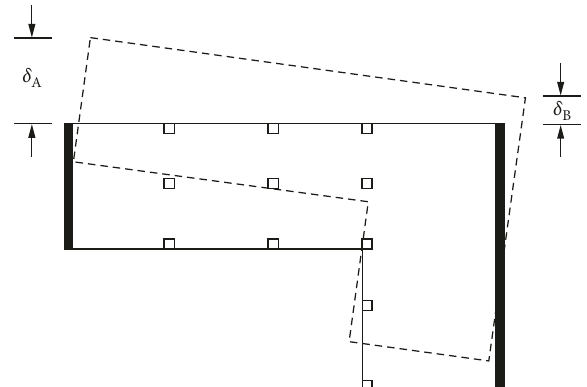
Figure 1: Determination of the average deflection δ from